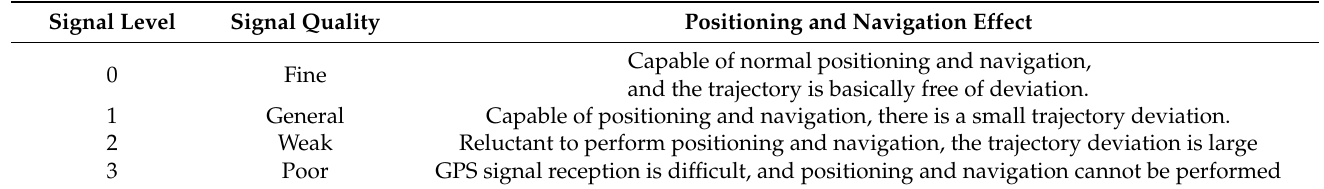
Table 1. GPS signal